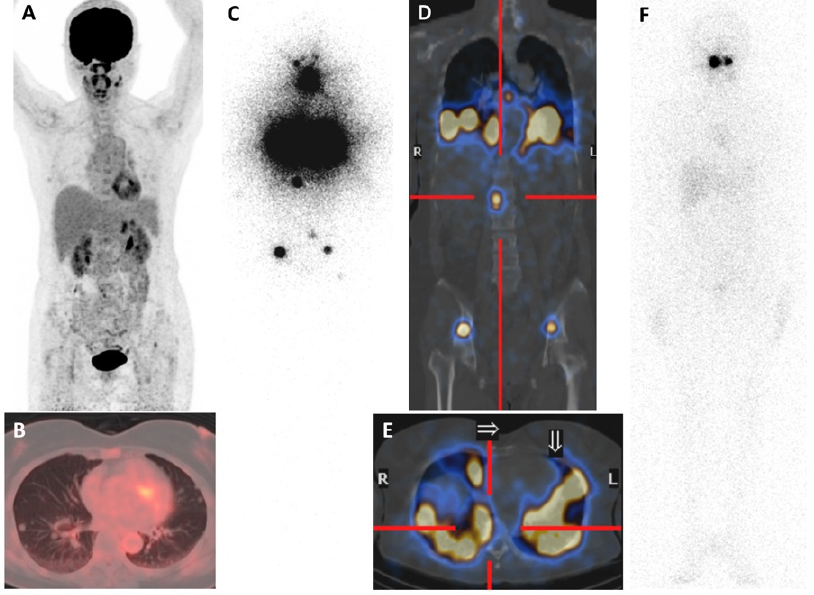
Figure 1. A 59-year-old woman with PTC with lung and bone metastases. She was initially investigated by [ 18 F]FDG PET/CT due to multiple lung nodules on chest radiograph. [ 18 F]FDG maximum-intensity (MIP) skull-to-mid-thigh PET ( A ) and axial fused PET/CT ( B ) images showed non-FDG-avid small lung nodules. Subsequently, wedge resection of the superior segment of the right lower lung lobe revealed metastatic well-differentiated follicular-derived thyroid carcinoma. After total thyroidectomy, the pre-therapeutic (2 mCi) 131 I WBS ( C ), coronal ( D ), and axial ( E ) fused SPECT/CT images showed intense iodine uptake in residual thyroid, diffuse lung, and bone metas- tases. She received 131 I therapies (cumulative dose of 600 mCi). ( F ) The last post-therapeutic 131 I WBS image revealed resolution of all iodine-avid lesions, and serum-stimulated Tg declined (<1 ng/mL), implying an excellent